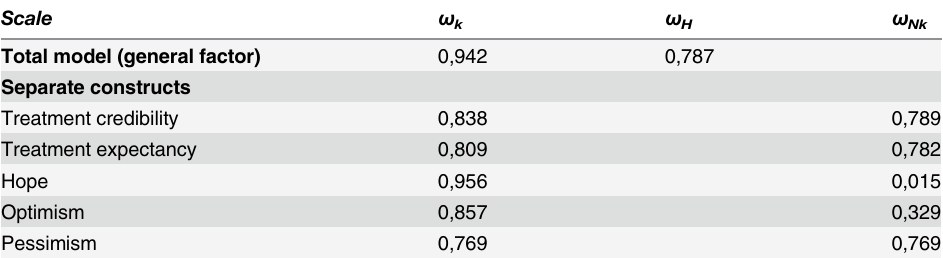
Table 5. The proportion of variance explained by all factors ( ω k ), the proportion of variance of the total scale explained by the general factor ( ω H ) and the proportion of variance of the separate con- structs explained by the specific factors ( ω Nk